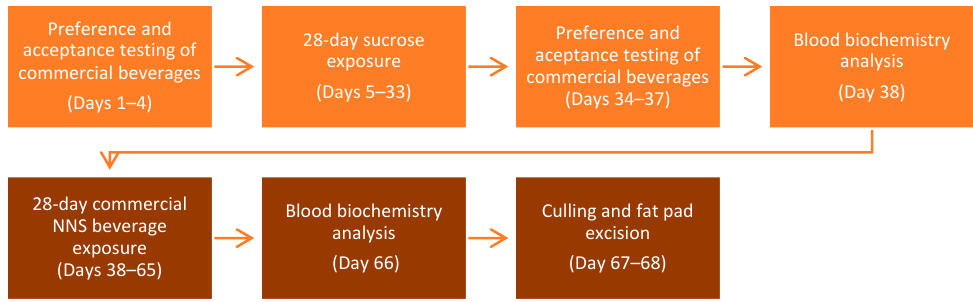
Figure 1. General timeline of all the procedures during the two phases of the experiment.